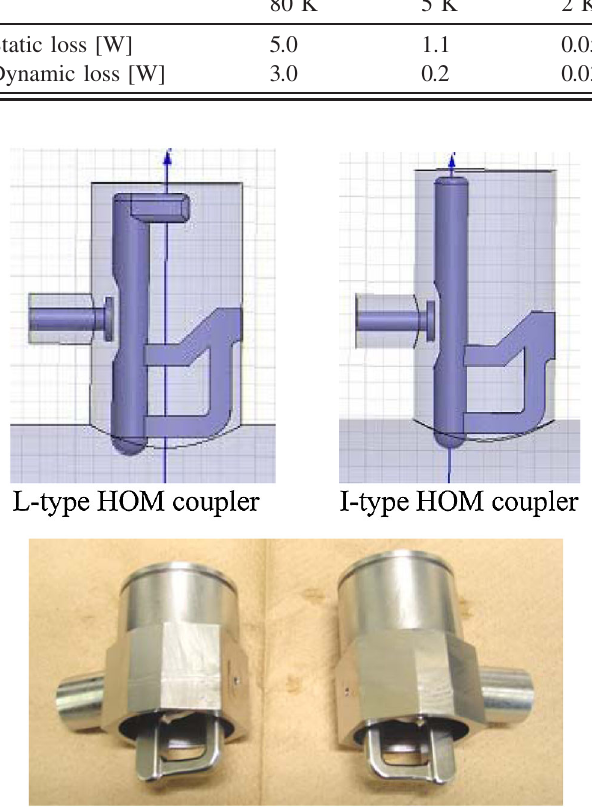
FIG. 4. (Color) Two types of HOM couplers.